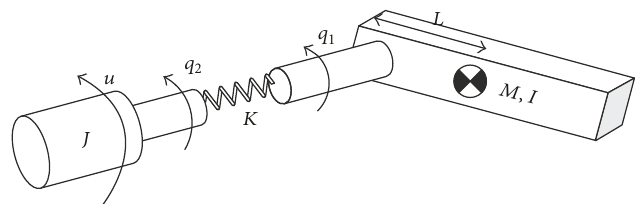
Figure 3: Single-link flexible joint manipulator.